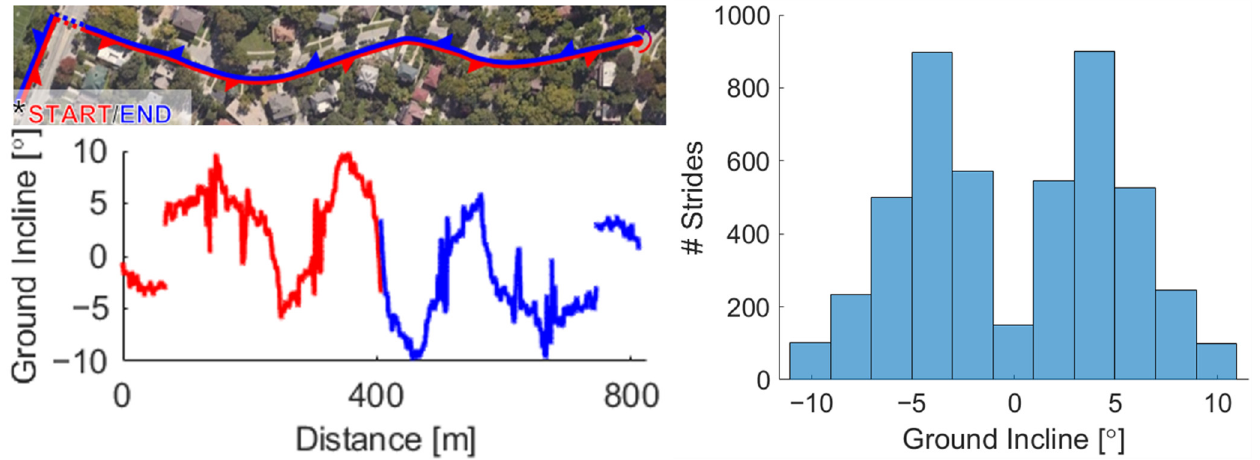
Figure 2. The outdoor course covered a continuous range of inclines from − 10° to +10°. Note that a crosswalk was omitted for safety (shown as a gap in the trace). This path was traversed in both directions to balance inclines and declines, yielding 4777 strides for analysis across 11 participants. Grouping strides by two-degree bins of slope, at least 100 strides were included in each bin.